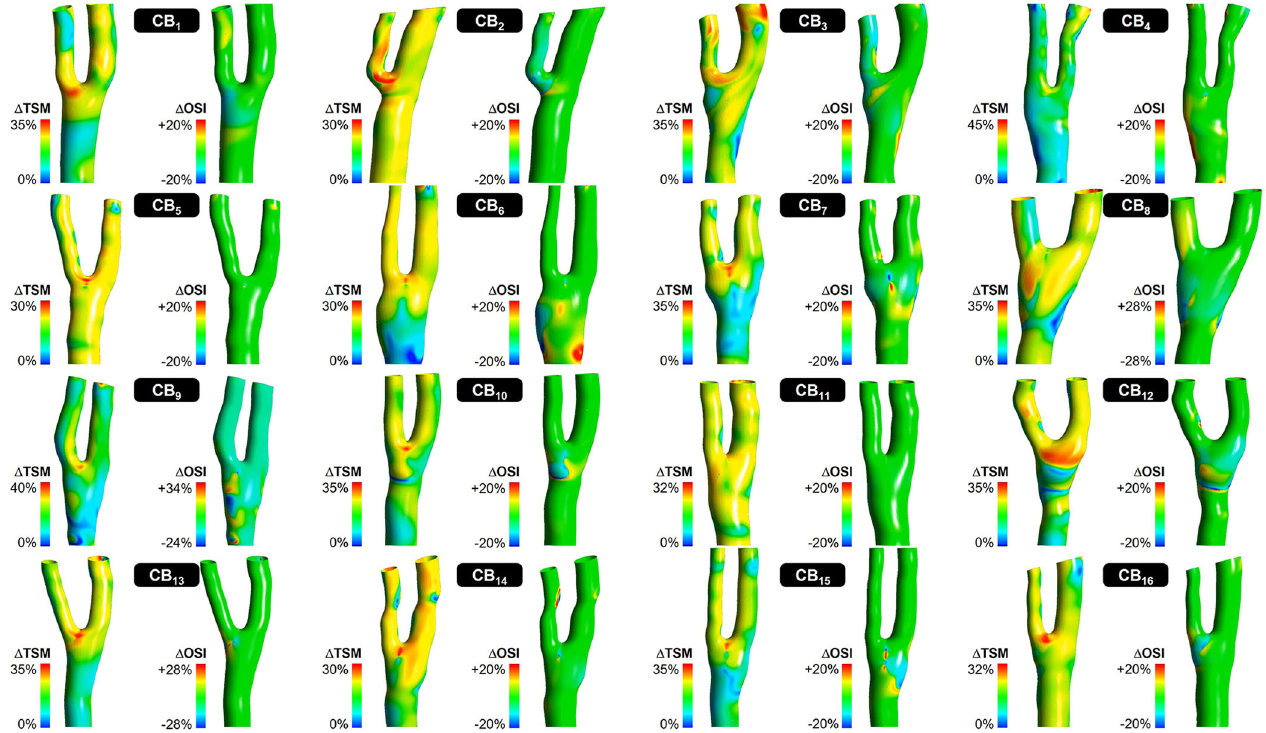
Fig. 3 Changes in local WSS characteristics predicted between 1G and 0G in the 16 carotid bifurcation models. For each model, the left panel shows the local changes in TSM ( Δ TSM), while the right panel shows the local changes in OSI ( Δ